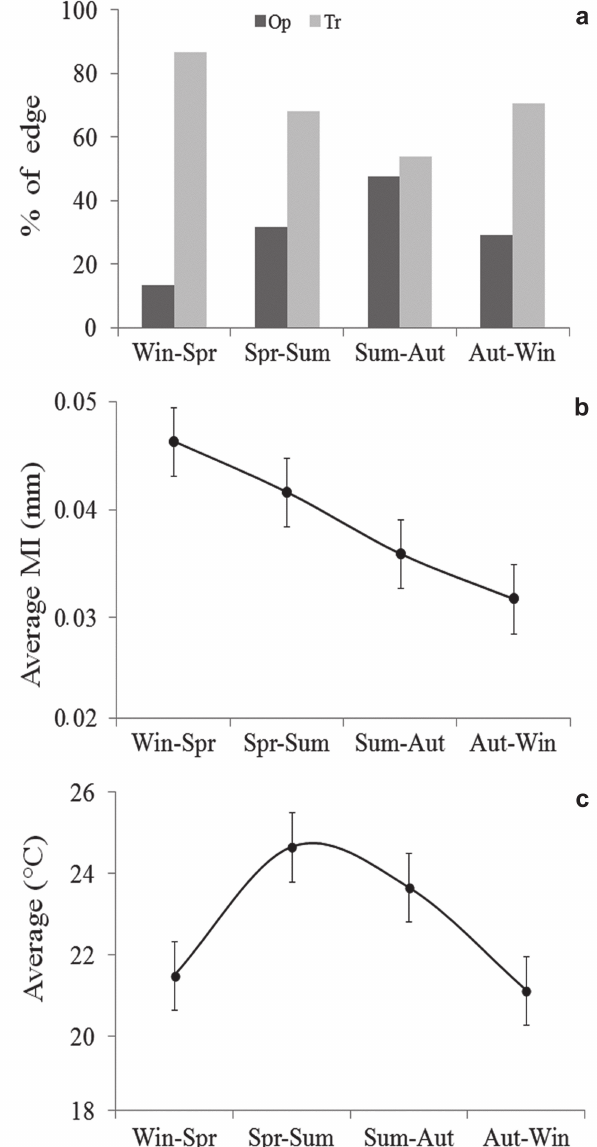
Fig. 4. a. Percent of seasonal frequency of opaque (OP, gray) and translucent (TR, white) edges in sagittae otoliths of Micropogonias furnieri ; b. Seasonal average marginal increment (MI, mm) and confidence limits obtained in sagittae otoliths of M. furnieri ; c. Average water temperature and confidence limits in waters for Ubatuba Bay.